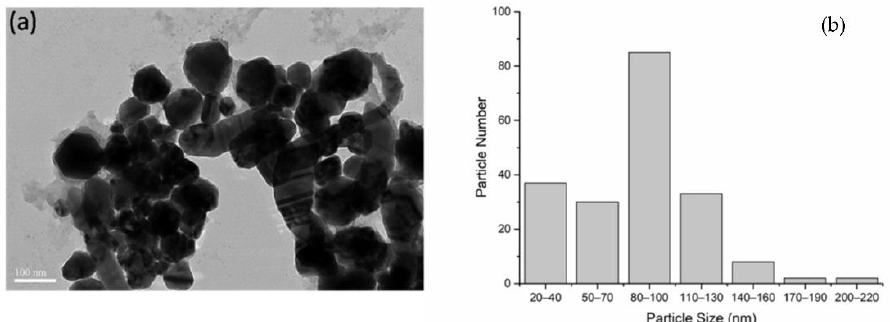
Figure 2. TEM image ( a ) and size distribution ( b ) of silver nanoparticles.